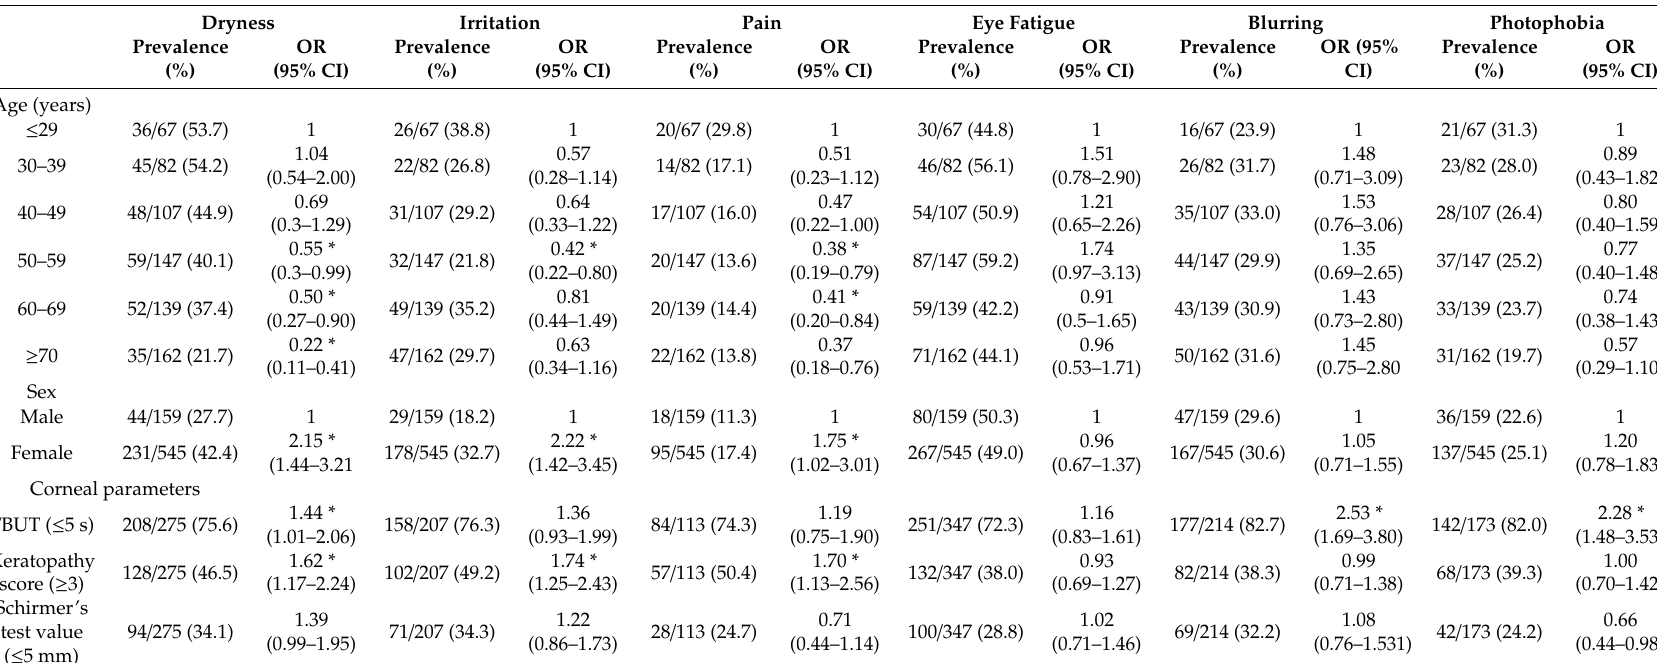
Table 2. Association between demographics, corneal parameters, and dry-eye-related